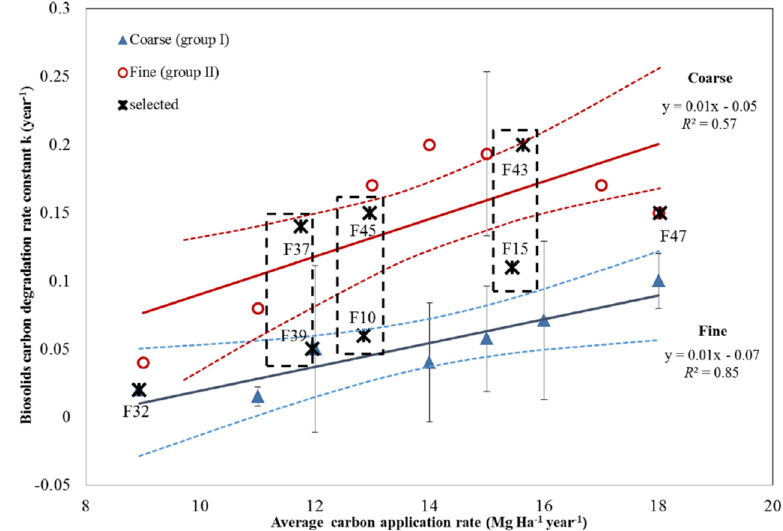
Figure 3. Biosolids degradation rate as a function of average annual carbon application rate separated into coarse and fine soil types (group I and II). Also identified are the eight fields used in this study including fields with similar application rates (paired field) and different soil types with 95% confidence interval shown for each soil group. The soil groups are from Tian et al. database